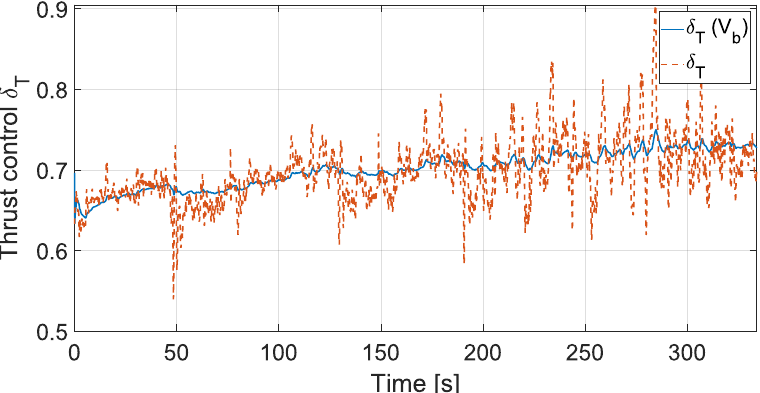
Figure 16. Comparison between the control signal δ T recorded during the validation flight and the one obtained from the inverse function of Equation (33).